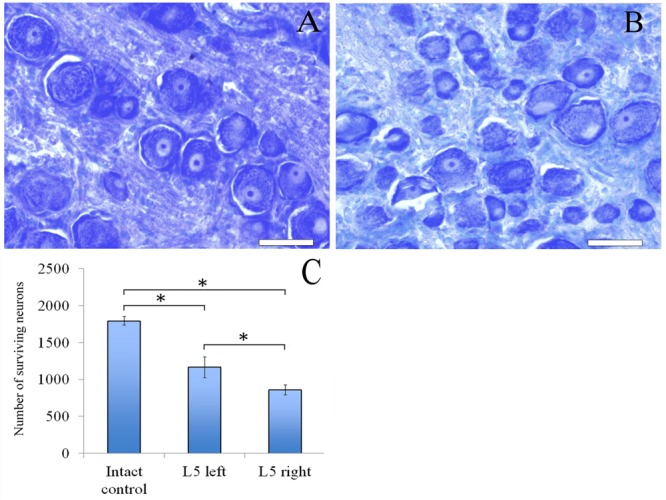
Neurons of L5 spinal ganglion. (A) Neurons of L5 left spinal ganglion, (B) neurons of L5 right spinal ganglion. Top: histological staining with azure-eosin. Bar: 200 μm. (C) Number of surviving neurons of L5 spinal ganglia: 1792.8 ± 58.8 (Intact, n = 6), 1166.1 ± 142.3 (L5 left, Experimental, n = 5) and 858.3 ± 66.2 (L5 right, Control, n = 5). Bottom: quantification of survived neurons of L5 spinal ganglia. Error bars represent standard error mean. Differences were statistically significant between the groups (∗), (∗P < 0.05, one-way ANOVA, Tukey’s test).